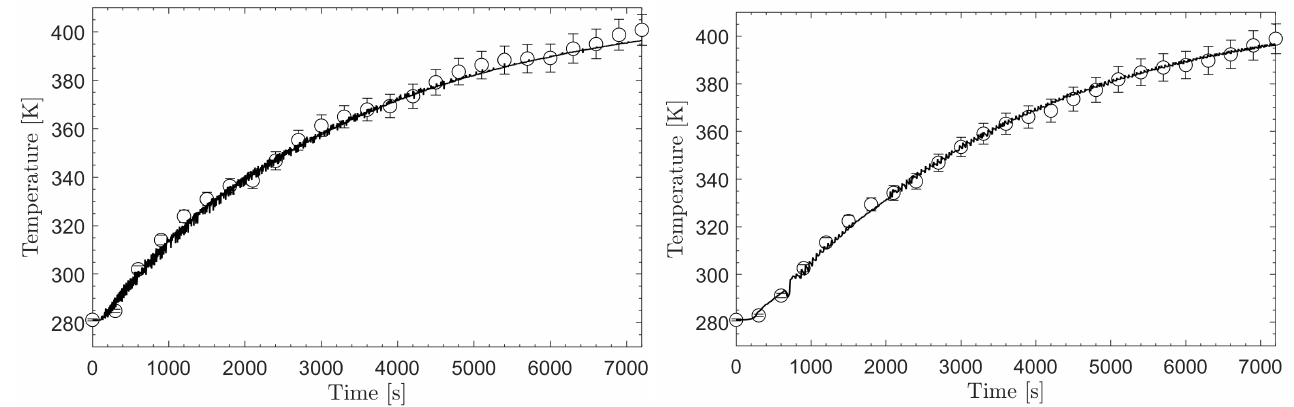
Figure 4. Validation of the numerical simulations. The experimental measurements are denoted by the symbols, and the error bars indicate the measurement error. Only 1 out of 30 experimental samples is shown. ( Left ) Temperature of the TES and ( Right ) temperature of the